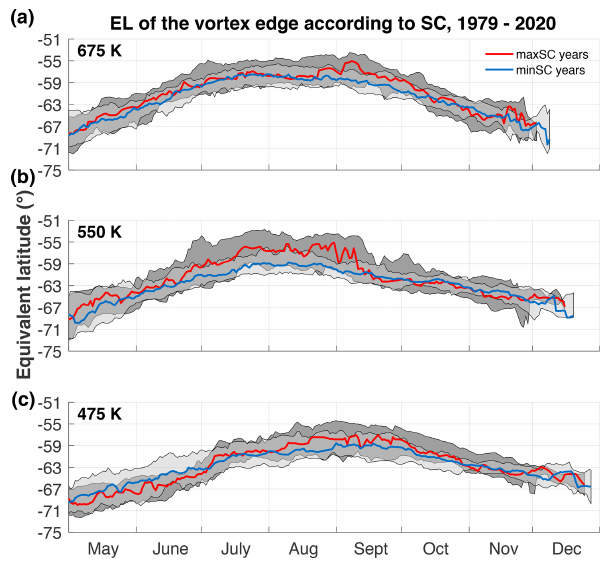
Figure 4. SC composites of the seasonal evolution of the vortex edge position according to SC for the period 1979–2020, from (a) to (c) : 675, 550, and 475K. Red curves represent median val- ues for maxSC years and blue curves for minSC years. Dark gray areas indicate values between the 20th and 80th percentiles for maxSC years and light gray areas for minSC years.